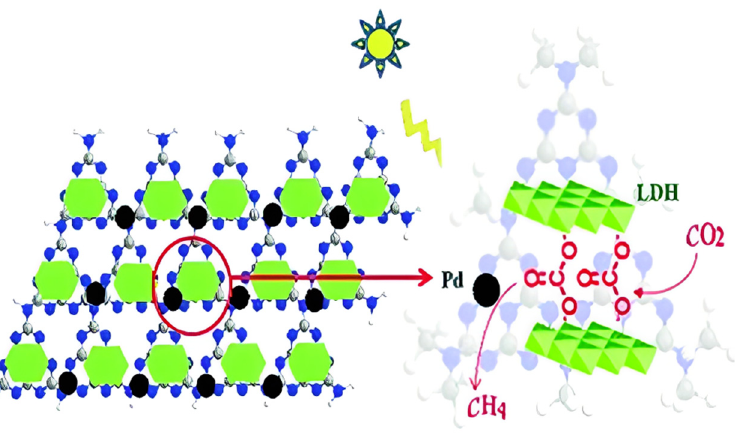
Figure 12. Schematic diagram of the self-assembly of carbon nitride (C 3 N 4 ) and MgAl-LDH for CH 4 production with Pd as cocatalyst [73].